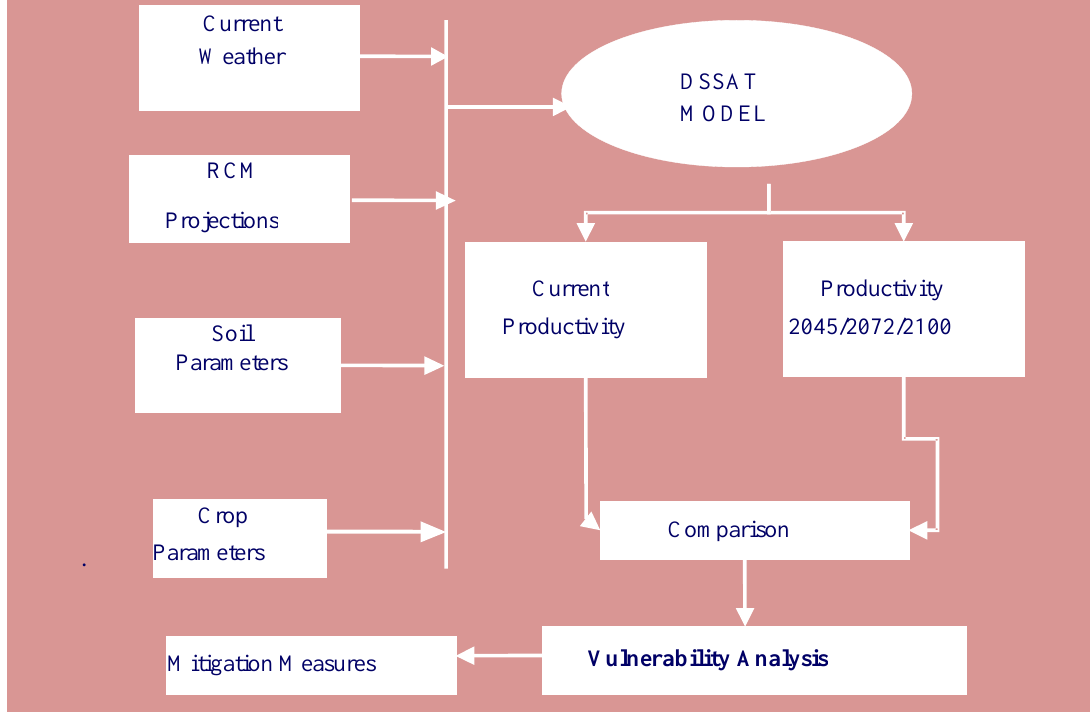
Figure 3: Schematic diagram of methodology applied